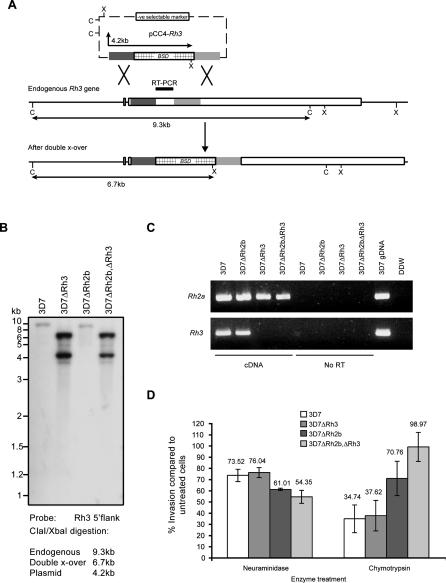
Targeted Disruption of PfRh3 Shows It Is Not Essential for the 3D7ΔRh2b Chymotrypsin-Resistant Pathway(A) Disruption of the PfRh3 gene in 3D7. The pCC4-Rh3 plasmid contains the blasticidin-S deaminase selectable marker, a negative selectable marker (A. G. Maier and A. F. Cowman, unpublished data), and 5′ and 3′ Rh3 regions. PfRh3 is shown with homologous target sequences (shaded regions). The double-crossover integration events are shown for 3D7, resulting in the deletion of a 5′ region of the gene. Restriction enzymes are C (ClaI) and X (XbaI), with fragment sizes shown for a C/X digestion. RT-PCR amplification target is shown as a black bar.(B) Southern blot of genomic DNA from parasites shown digested with ClaI and XbaI and probed with the 5′ Rh3 flank from the pCC4-Rh3 vector.(C) RT-PCR of PfRh2a and PfRh3 from 3D7 and three knockout lines.(D) Invasion into enzyme-treated erythrocytes expressed as a percentage of that into untreated erythrocytes for 3D7 and three knockout lines. Values above each column indicate the mean % invasion, with error bars representing the 95% CI from three independent assays.